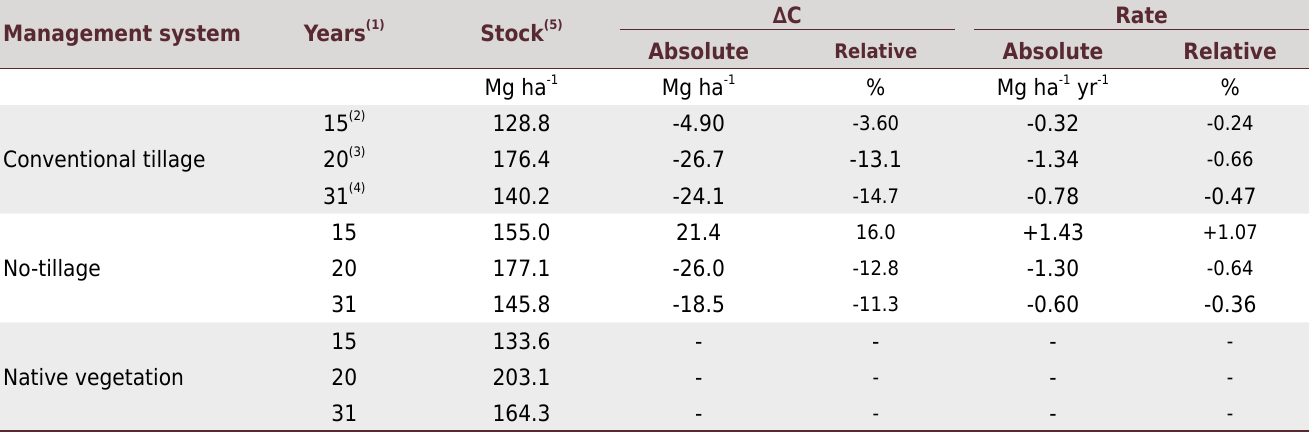
Table 5. Absolute and relative changes in C stocks in a clayey Latossolo Vermelho Distrófico (Typic Haplustox) in the 0.00-1.00 m depth range after 31 years of a long-term experiment in the Cerrado , according to different studies Management